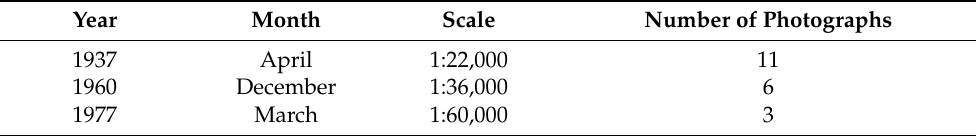
Table 1. Summary of the historical aerial photographs data.